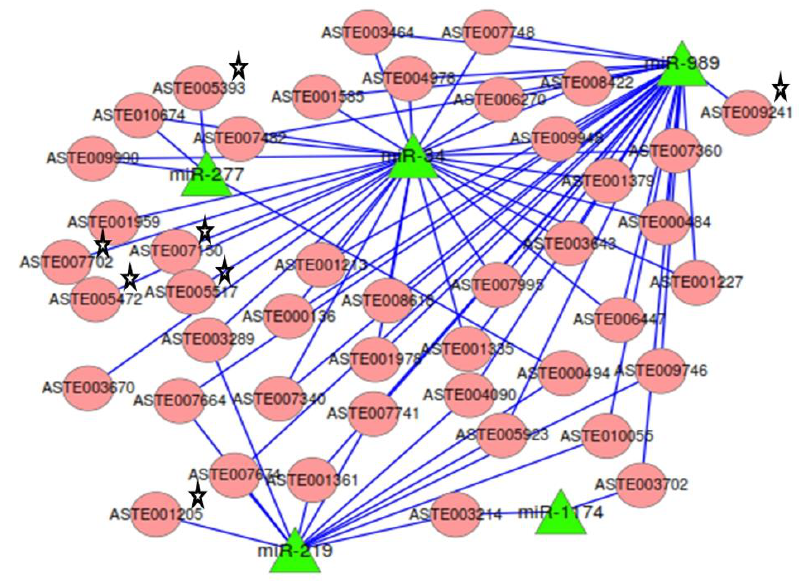
Figure 7. Network of miRNA:mRNA interactions. Network of five miRNAs expressed in the midgut tissue of female mosquito and their targets including the ones functional in oxidative stress and innate immunity. All miRNAs are depicted as a green colored node. Targets are depicted in circular and red colored nodes. Targets validated by miRNA loss of function are marked with